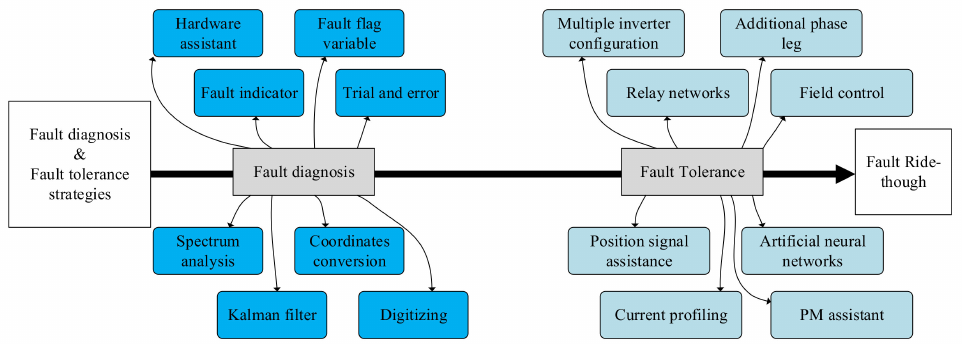
Figure 19. Classification of fault diagnosis and fault tolerant methods edited from